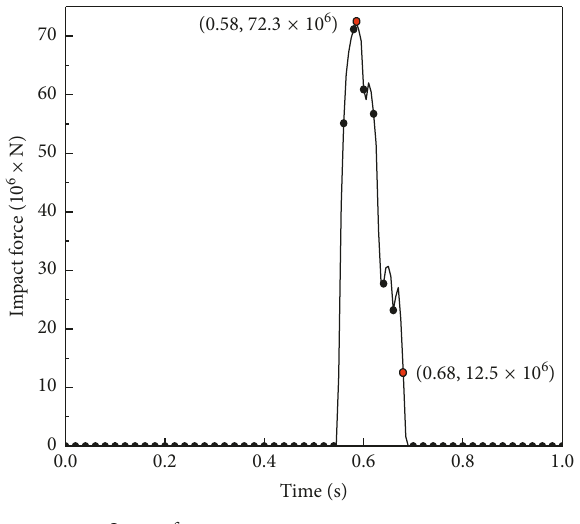
Figure 19: Peak of stress at different longitudinal positions.